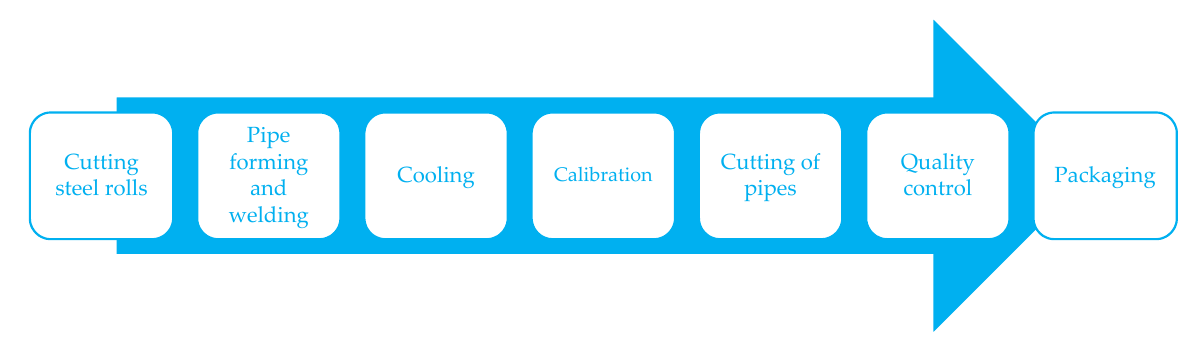
Figure 2. Diagram of the production process in the analyzed enterprise.